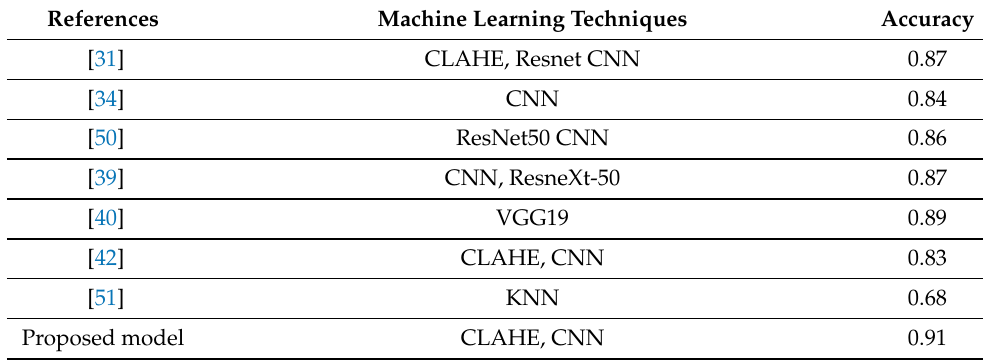
Table 5. Comparison of proposed method with other methods reported in the literature.